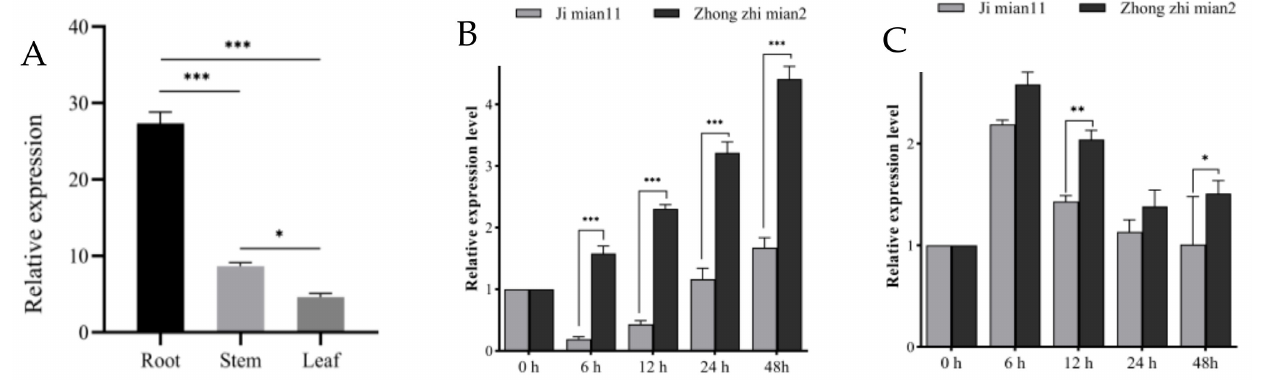
Figure 11. Expression pattern of GhPAT27 . ( A ) Expression of GhPAT27 in different tissues; ( B ) Expression level of GhPAT27 in the roots of Zhong zhimian 2 and Jimian 11; ( C ) Expression level of GhPAT27 in the stems of Zhong zhimian 2 and Jimian 11. The relative expression of GhPAT27 was all calculated based on the control gene GhUBQ7 . Three technical replicates and three biological replicates were set up for each experiment. Statistically significant differences from the control group are indicated as * p < 0.05; ** p < 0.01; *** p <